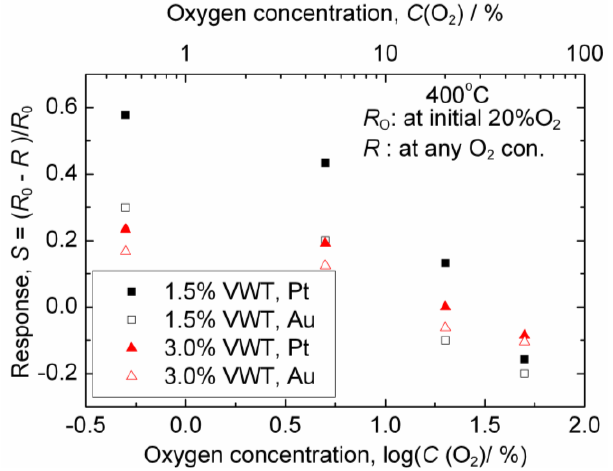
Figure 6. Oxygen concentration dependence of the sensor resistance at T = 400 °C.